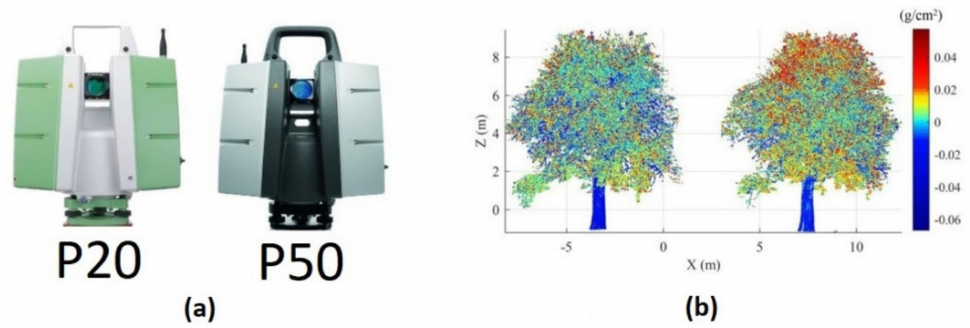
Figure 5. ( a ) The Leica P20 and P50 TLS instruments; ( b ) EWT point clouds of a Swedish whitebeam tree in August ( left ) and October ( right )